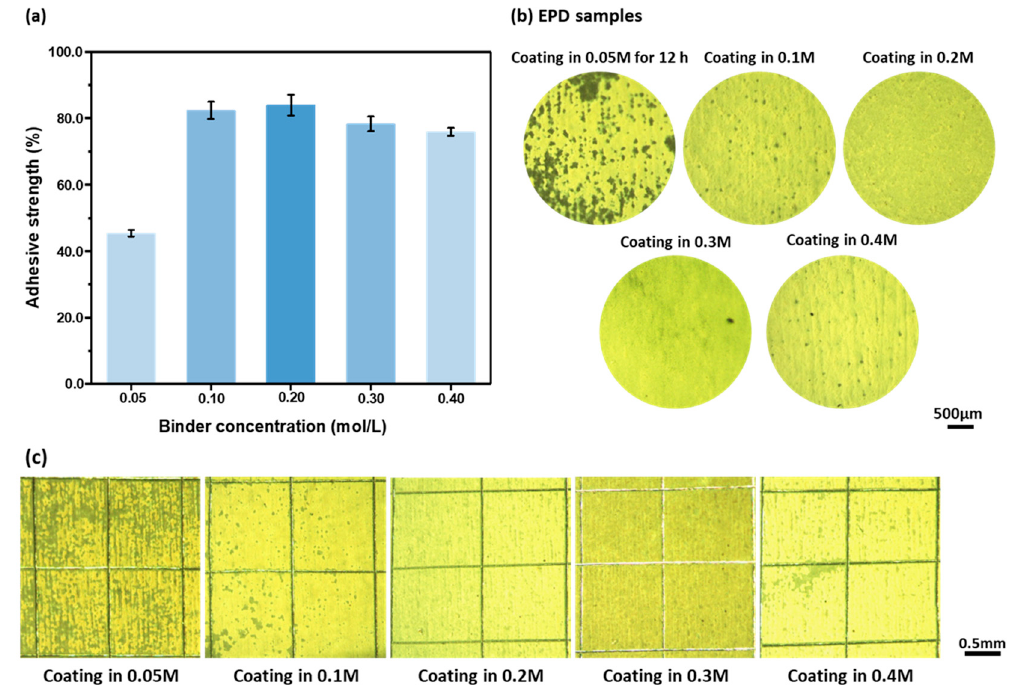
Figure 13. Adhesive strength of the coating soaked in Al(H 2 PO 4 ) 3 solution with different concentrations varying from 0.05 to 0.4 mol/L ( a ), corresponding microscopic images of the coatings after the adhesive strength test ( b ) and images of the coatings after the cross-hatching tests ( c ).